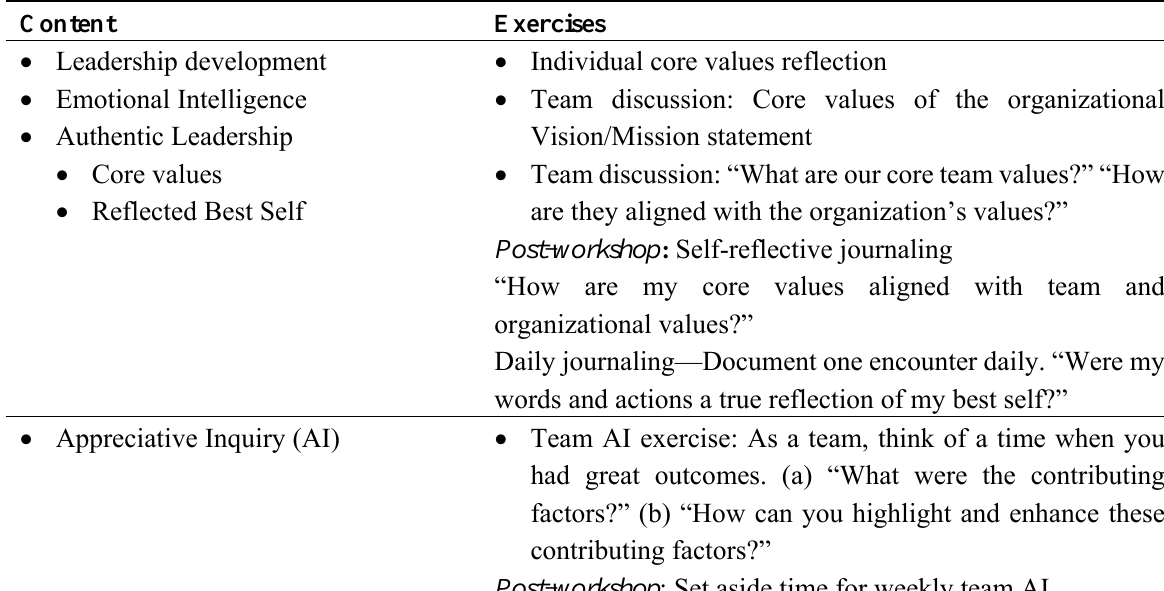
Table 2. Workshop agenda and